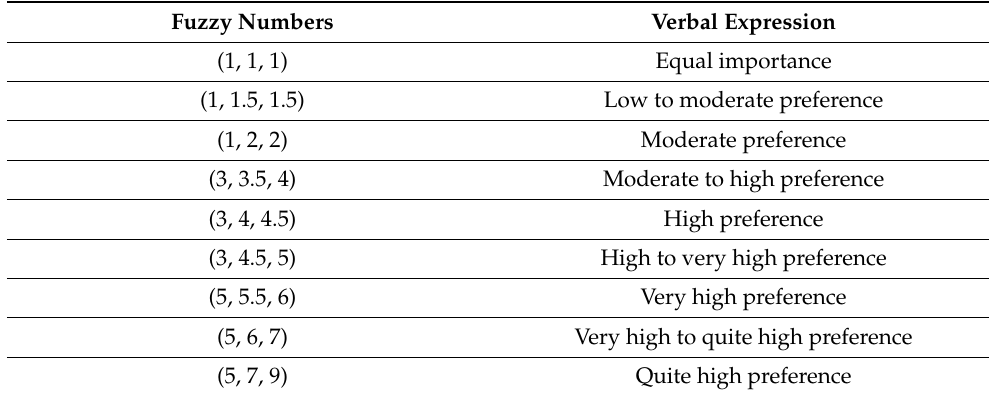
Table 3. Linguistic scales to express the degree of importance in